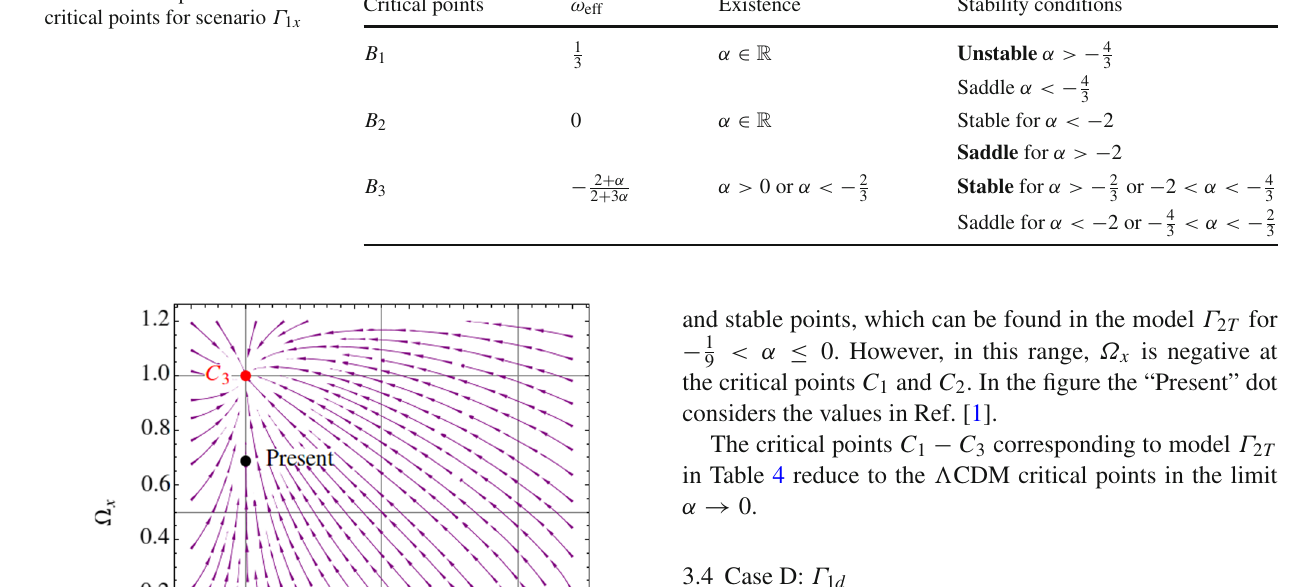
Table 3 Description of the